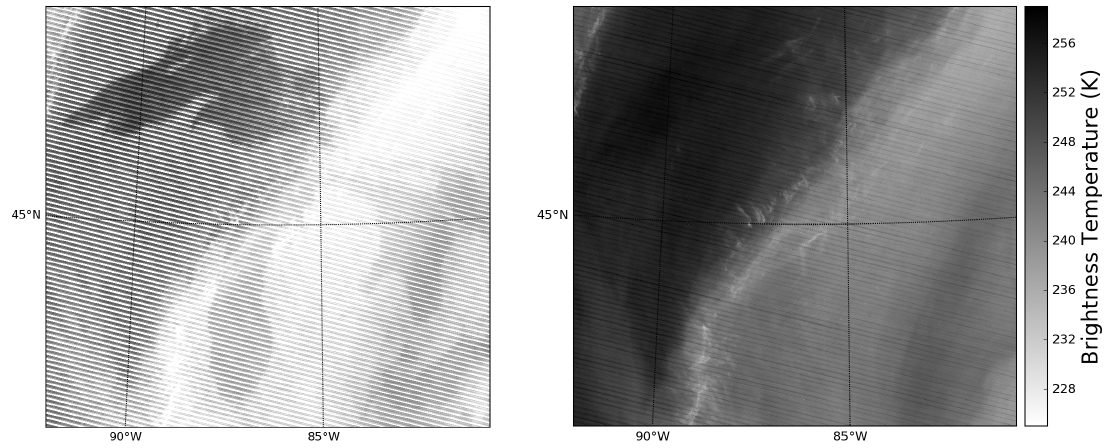
Figure 9. Example image correction for L1B data over the Great Lakes region on 22 May 2016 for Band 27 with the uncorrected image to the left and the corrected image to the